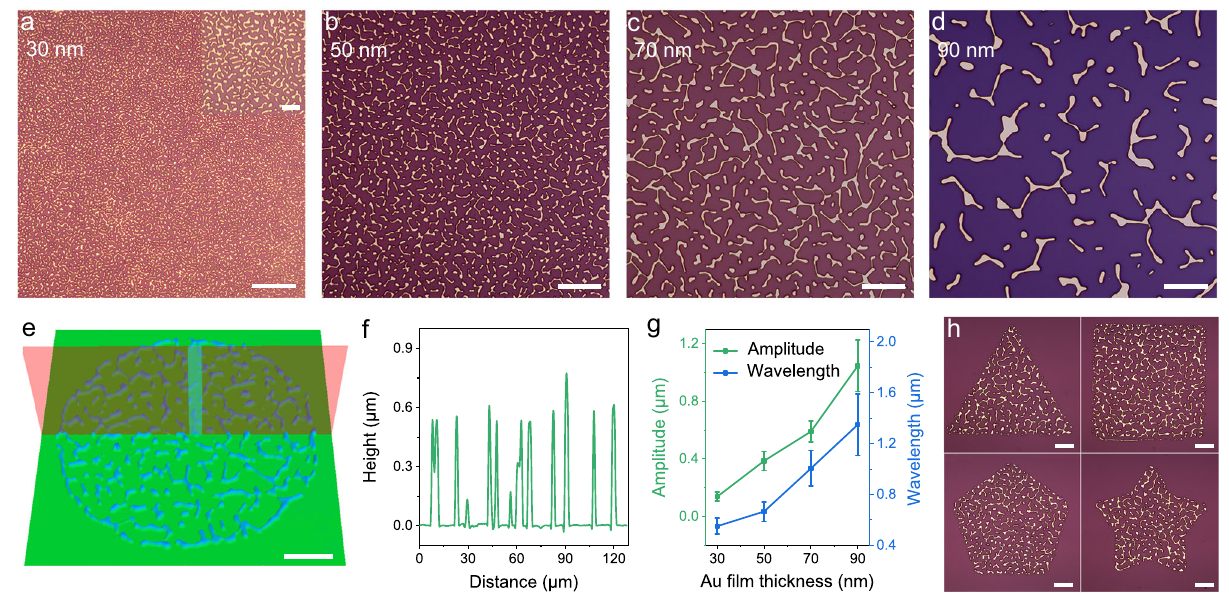
Fig. 2 | Con fi gurable network topography. a – d Optical micrographs of the ran- dom Au networks with different fi lm thicknesses (from 30 to 90nm). e Typical 3D topographyofanisolatedPUFtagforthe70-nm-thickAu fi lmand f cross-sectional pro fi le along the diameter. g Amplitude and wavelength of the networks with dif- ferent Au fi lm thicknesses, both showing a gradually increasing tendency with an